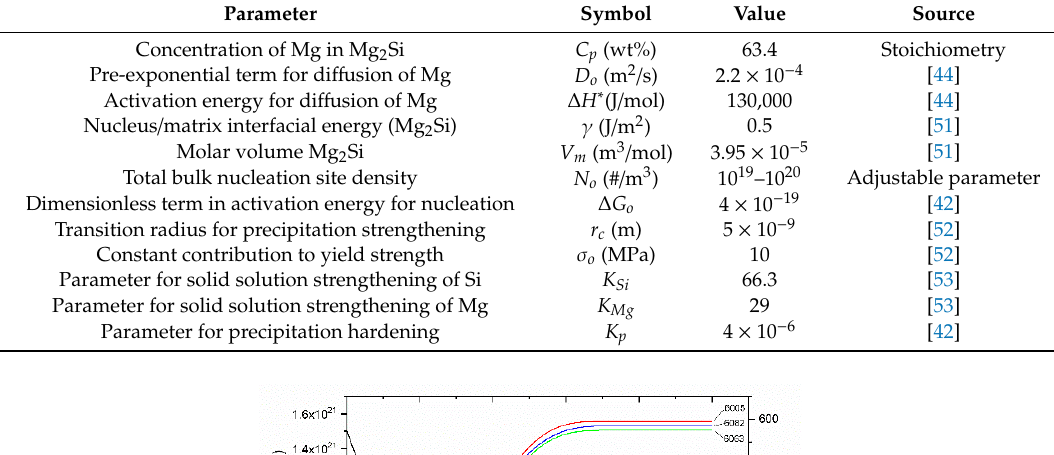
Table 4. Parameters used in the KWN and strength models for homogenization cooling.